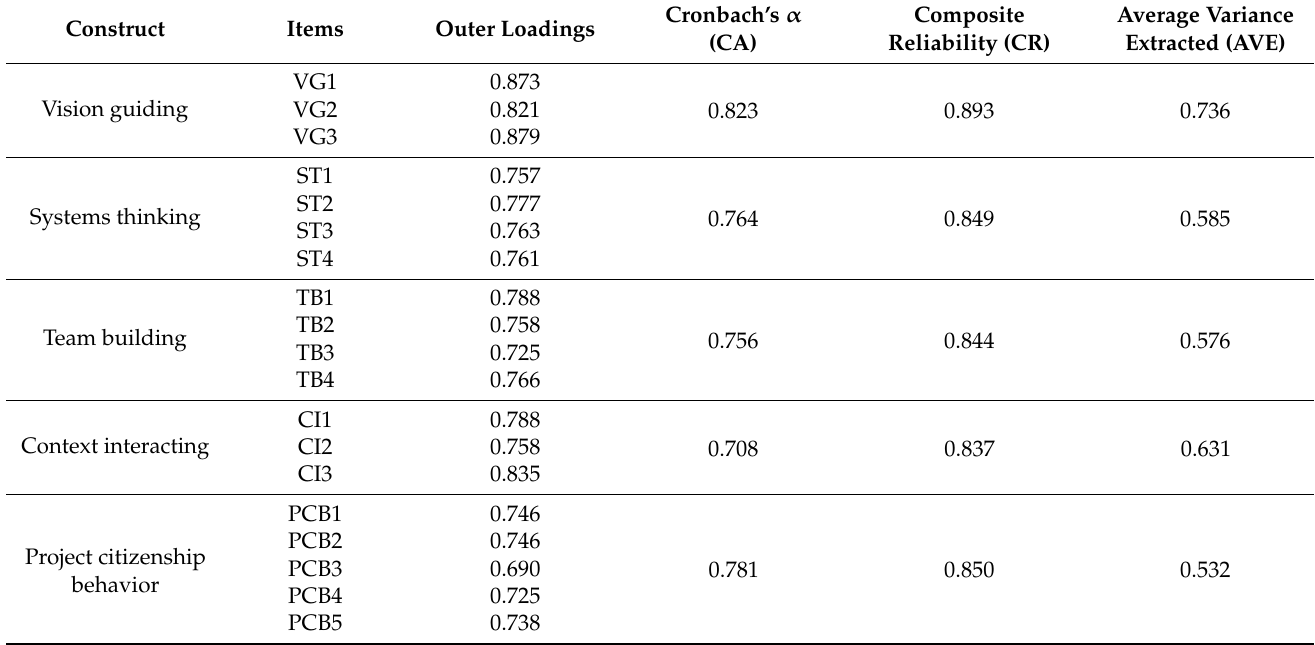
Table 7. Assessments of measurement model (reflective